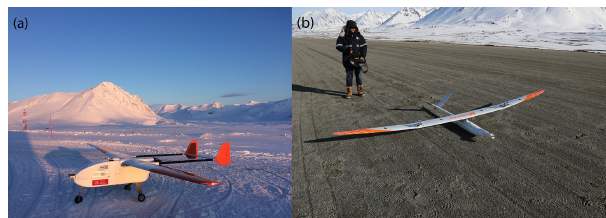
Figure 8. (a) The UAS ALADINA and (b) the UAS MASC3, both at the airport in Ny-Ålesund.